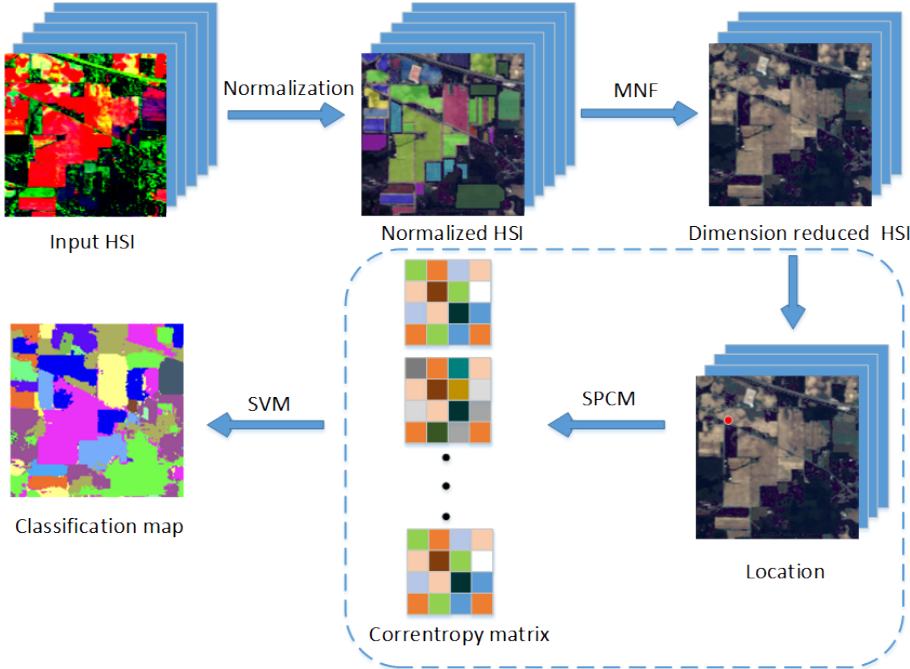
Figure 4. Image display is an HSI classification method based on SPCM. First, we perform dimension- ality reduction of a hyperspectral image based on MNF. Then we convert each pixel to a correntropy matrix in turn by SPCM. Finally, all the matrices are input to SVM for